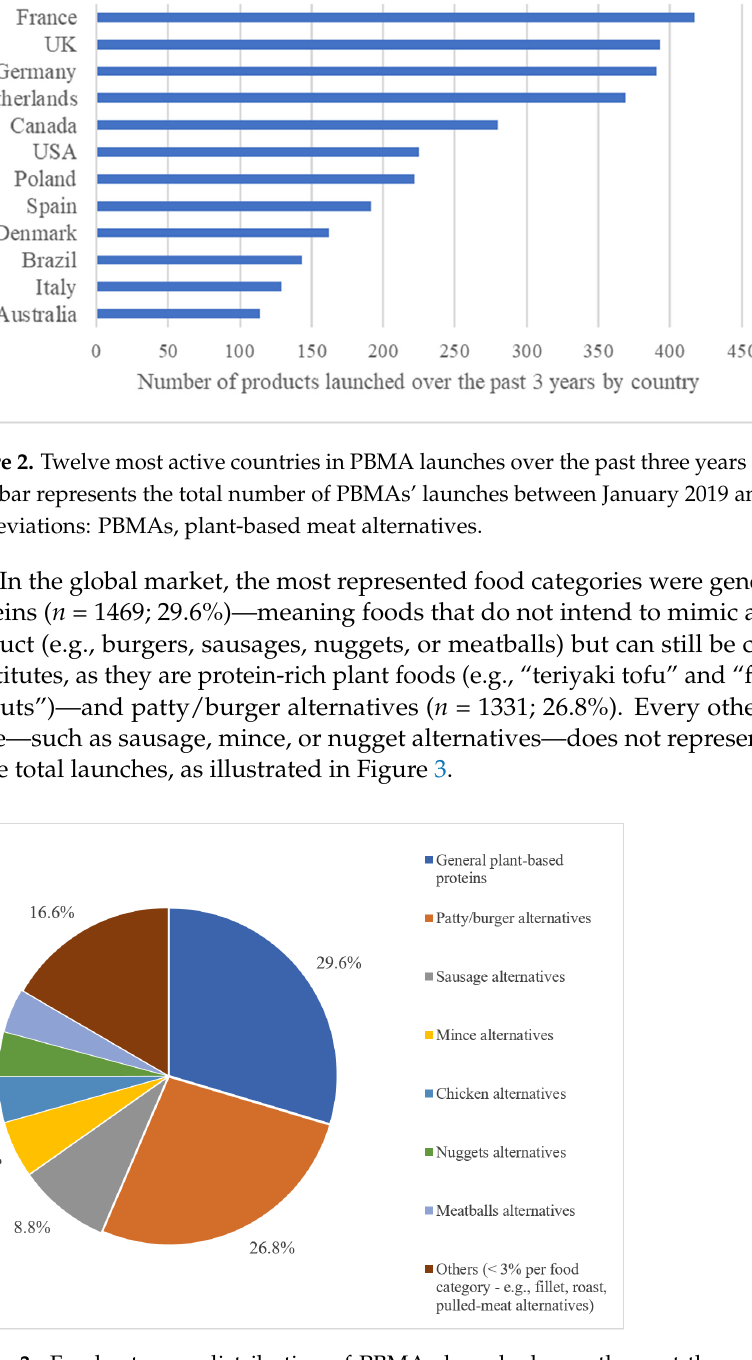
Figure 2. Twelve most active countries in PBMA launches over the past three years (2019–2021). Note: Each bar represents the total number of PBMAs’ launches between January 2019 and Decem- ber 2021. Abbreviations: PBMAs, plant-based meat alternatives.